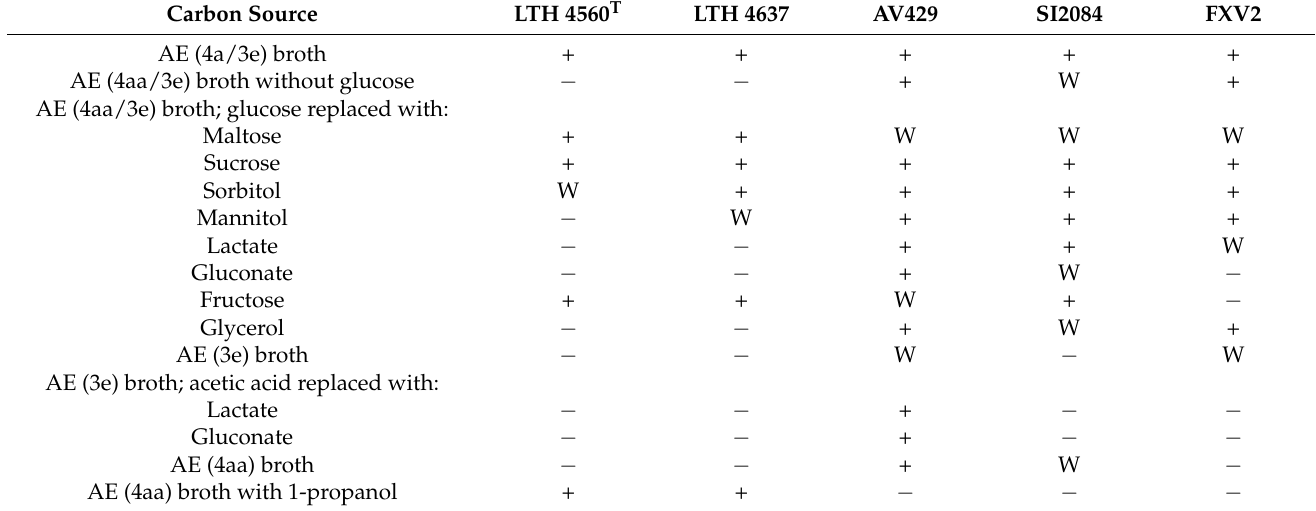
Table 3. Utilization of different carbon sources in AE (4aa/3e), AE (3e) and AE (4aa) broth by Gluconacetobacter entanii strains.